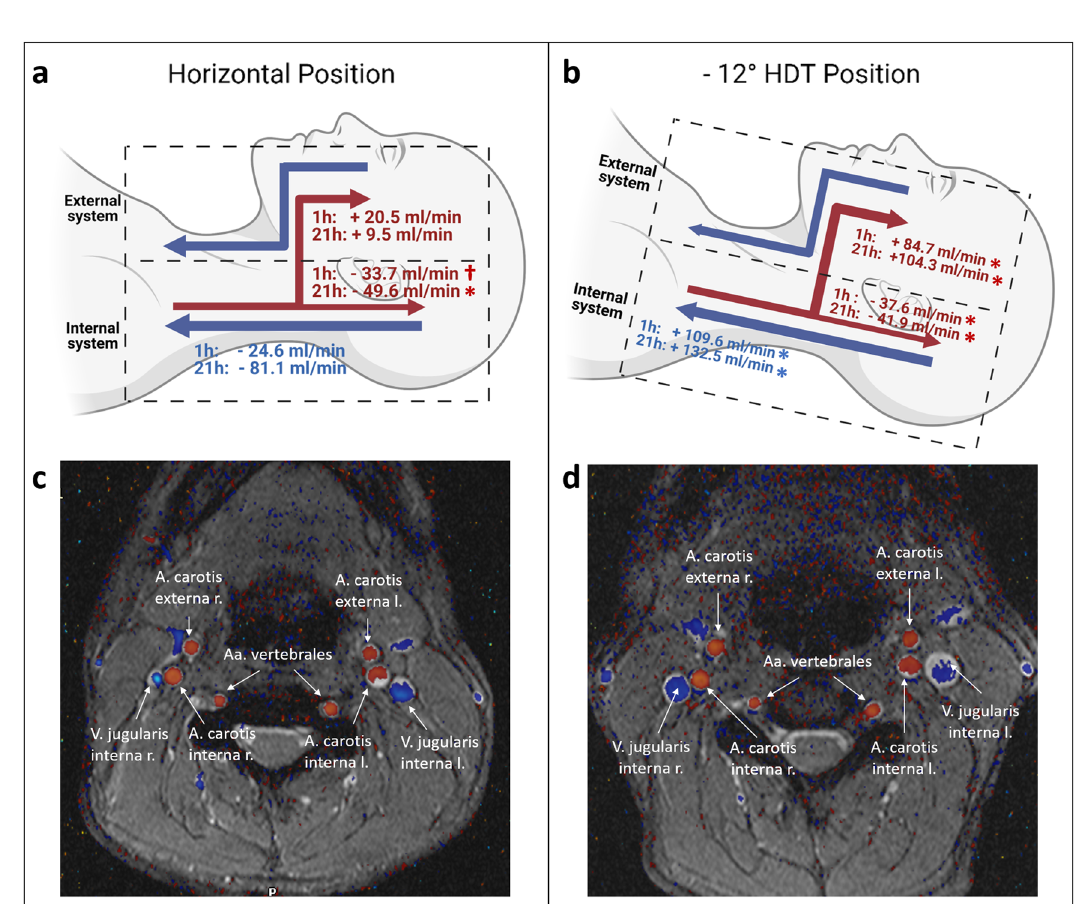
Fig. 1 Difference in cerebral blood fl ow after 1 h and 21 h of the intervention. The numbers in panel a and b indicate the difference in fl ow in each respective position in comparison to the baseline data. The external system comprises the external carotid (red). The internal system includes the internal carotid artery (red) and jugular vein (blue). Algebraic signs refer to the physiological fl ow direction of each vessel. Figure panels c and d show anatomical MRI images of one of the subjects on the fi rst interventional day in each of the respective body positions. † P < 0.05; * P < 0.001 (linear mixed effect models were used for statistical analysis). Panel a and b created with